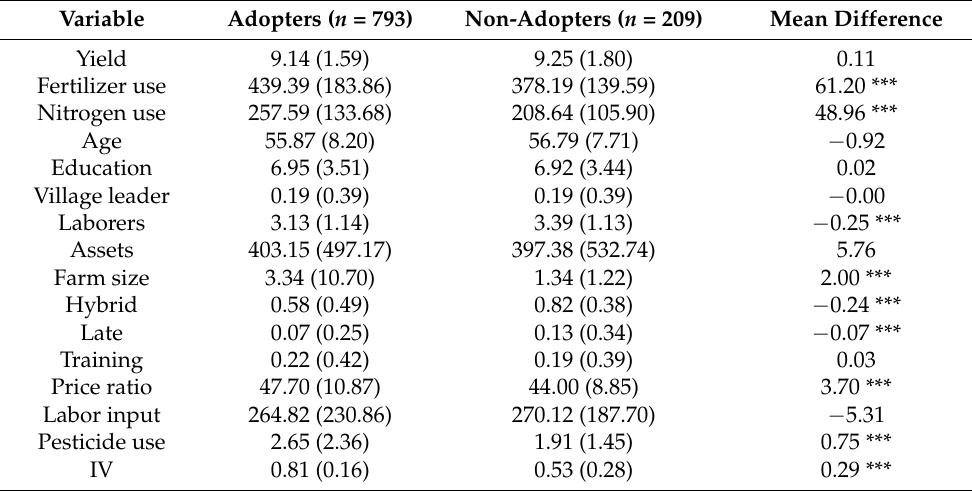
Table 2. Mean differences between the adopters and non-adopters of direct